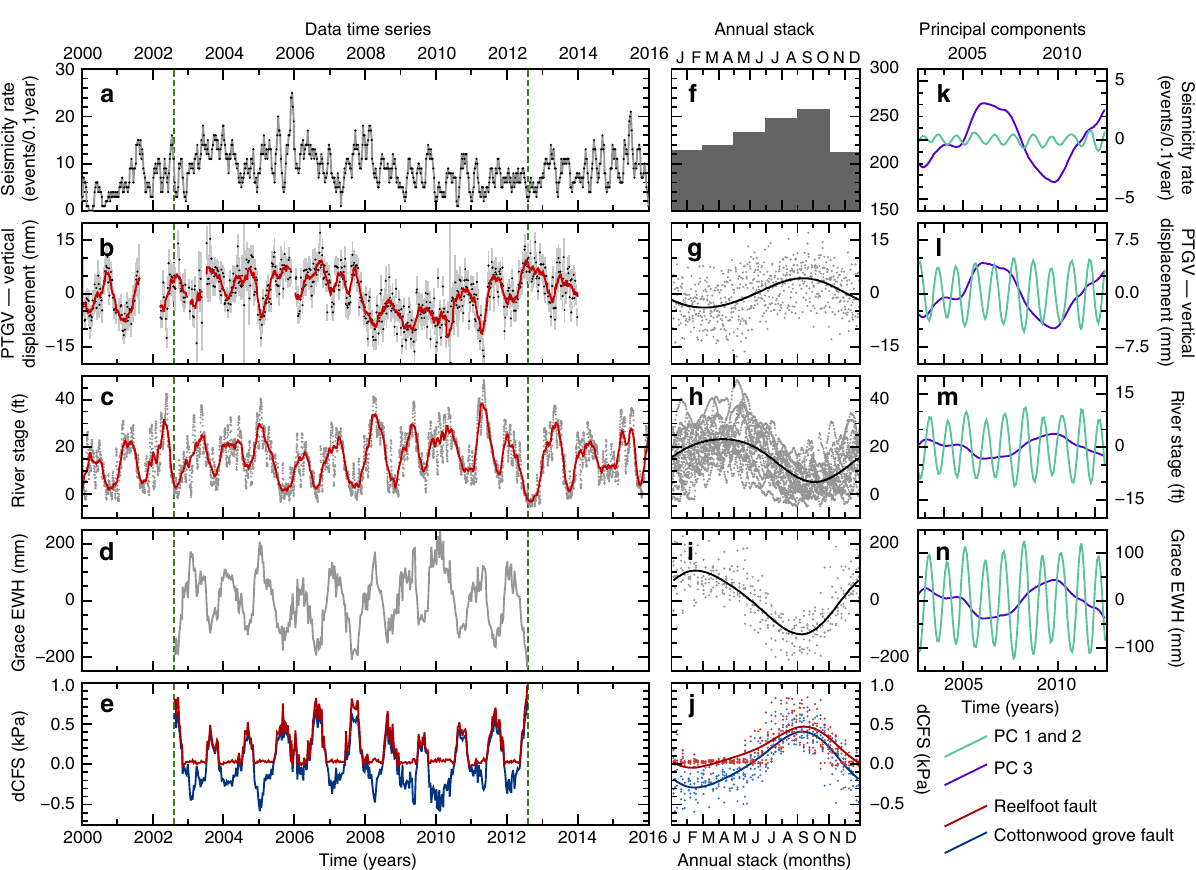
Fig. 6 Data time series annual stacks and M-SSA analysis. a Seismicity rate for the Reelfoot fault region (Fig. 1). b Vertical-component GPS displacements from site PTGV (black points), with 0.2-year running average (red). See Fig. 1a for site location. c River stage observations from New Madrid (orange triangle, Fig. 1a) with 0.2-year running average (red). d GRACE gravity observations for the New Madrid region. e Calculated Coulomb failure stress variations from GRACE loading variations for the Reelfoot fault (red) and Cottonwood grove fault (blue). f Earthquake frequency histogram, stacked on an annual timescale (as in Fig. 3d). g – j , as in b – e , but stacked on an annual timescale. Curves are a best- fi t four-component annual Fourier series to the stacked data. k – n The fi rst three principal components for seismicity rate, GPS displacement, river stage and GRACE gravity, respectively, as determined from Multi-channel Singular Spectrum Analysis (see Methods) on the time period common to all data time series (green dashed lines, a – e ). PCs 1 and 2 are both approximately annual, and are shown combined. PC 3 is a longer-term multi-annual signal common to all four data time series Ed: Please ask the authors to edit the title of fi gure 6 to